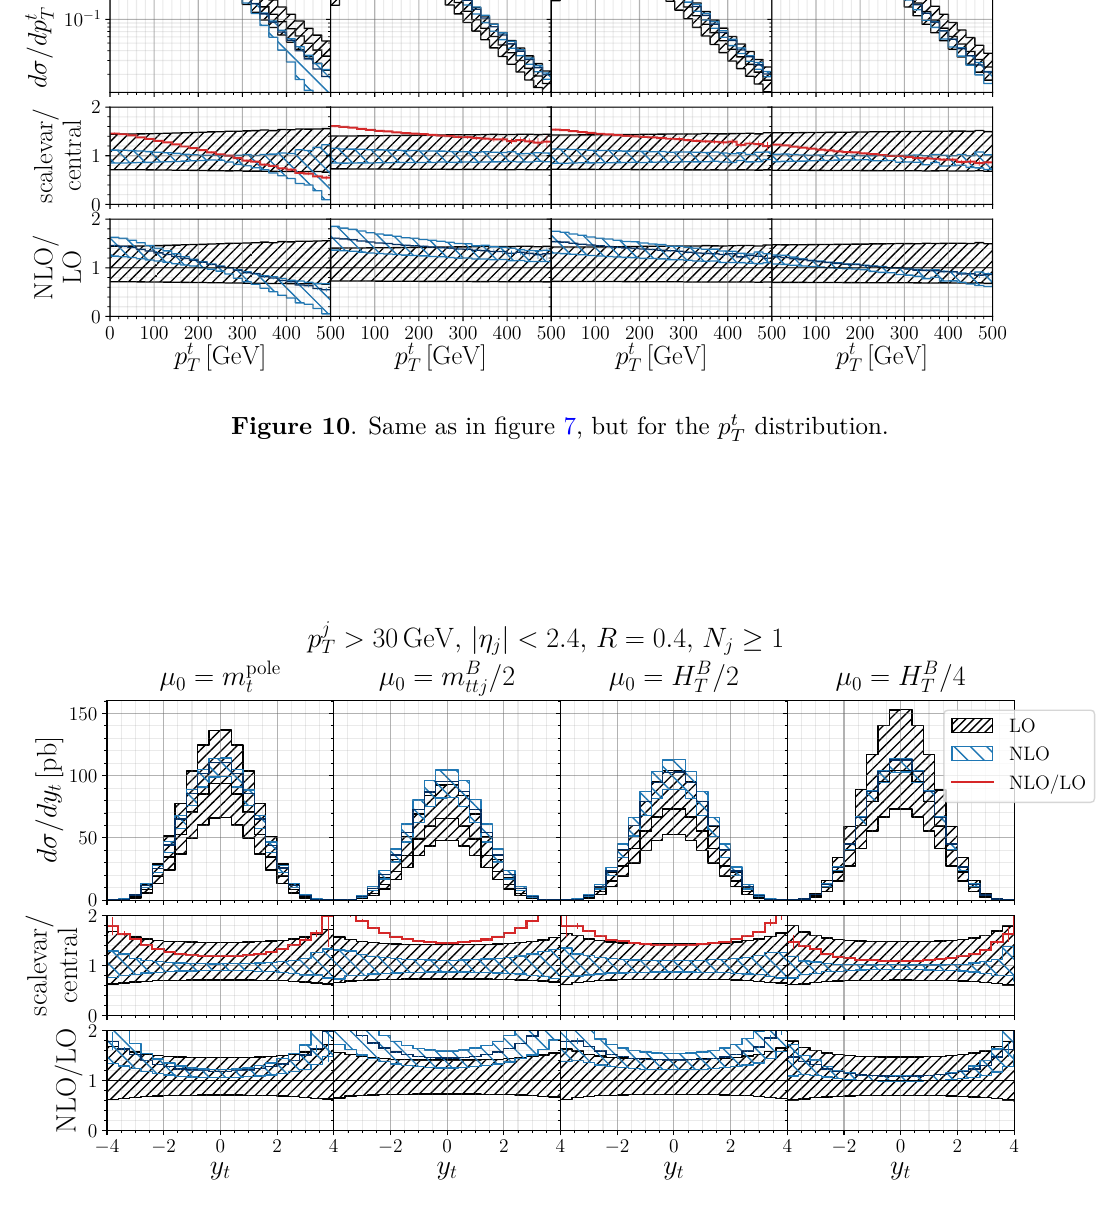
Figure 11 . Same as in figure 7, but for the y t